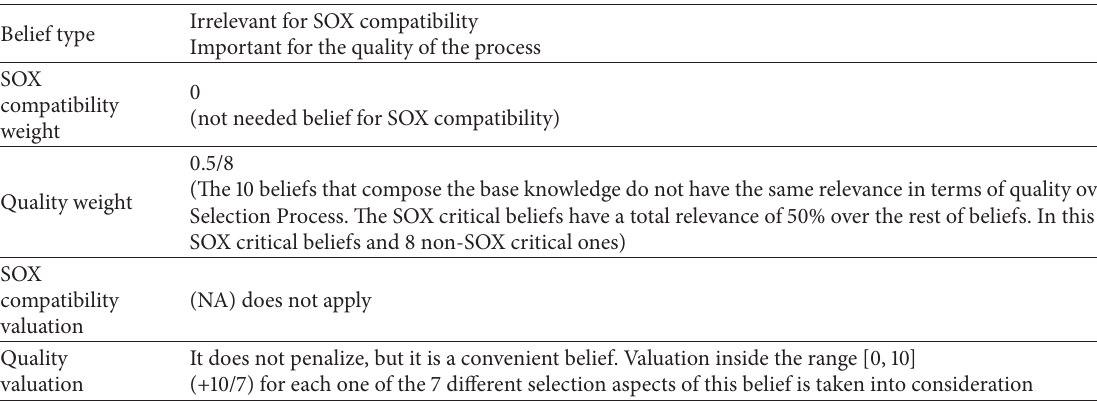
Table 10: Quality, Security and Processes Scoring